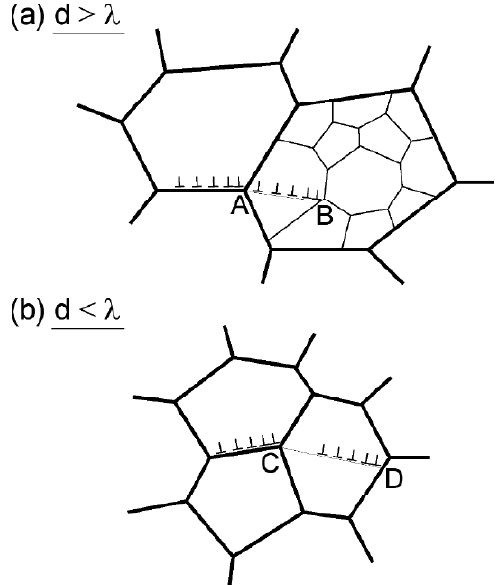
Fig. 2. Schematic illustration of a unified model for grain boundary sliding in (a) conventional creep when d >  and (b) superplasticity when d < 